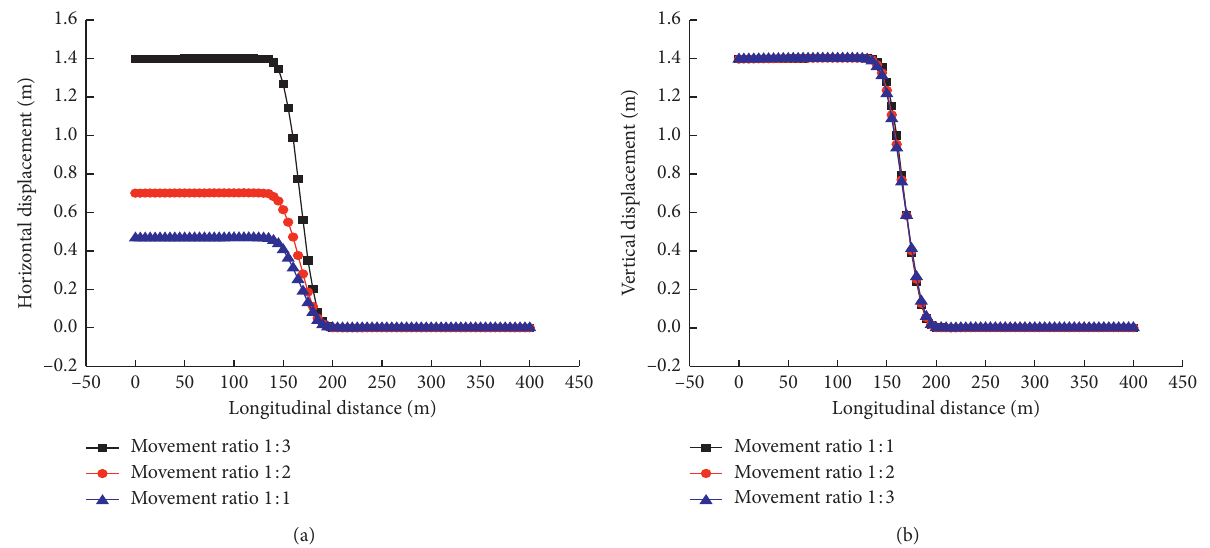
Figure 7: Displacement curves of tunnel lining with different movement ratios of 45 ° dip angle under coupling fault. (a) Y -direction lining displacement curve with different movement ratios under coupling fault. (b) Z -direction lining displacement curve with different movement ratios under coupling fault.